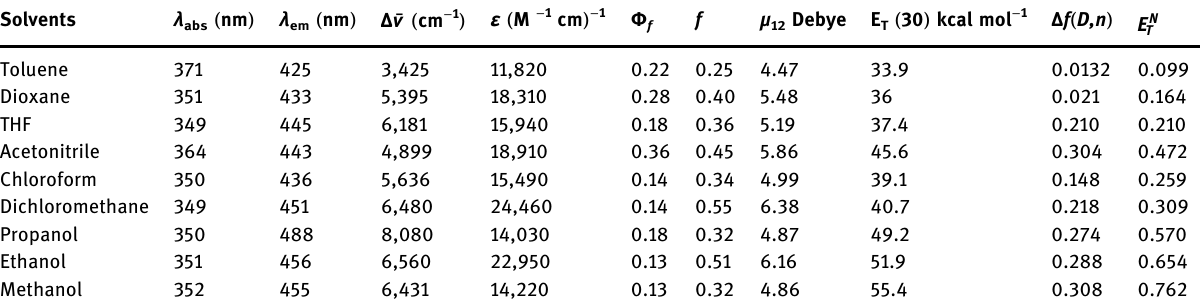
Table 1: Spectral and photophysical parameters of DTPP in di ff erent solvents Solvents λ abs ( nm ) λ em ( nm )